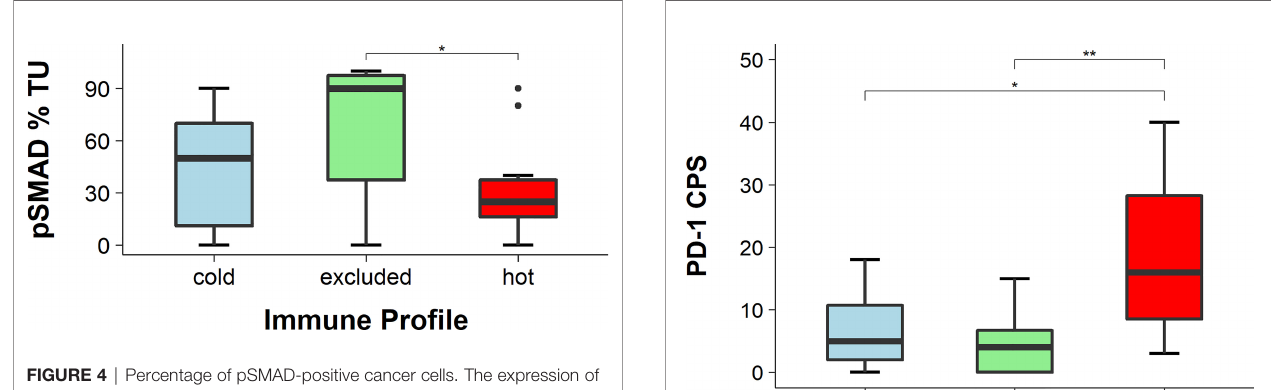
FIGURE 4 | Percentage of pSMAD-positive cancer cells. The expression of pSMAD was the highest in cancer cells of excluded tumors and the lowest in hot tumors, while in cold tumors it was in between. The difference in pSMAD expression between excluded and hot tumors was statistically signi fi cant ( p < 0.05), while the expression difference in cold tumors was not statistically signi fi cant in either of the two other tumor immune types (both p > 0.05), * means p<0.05.